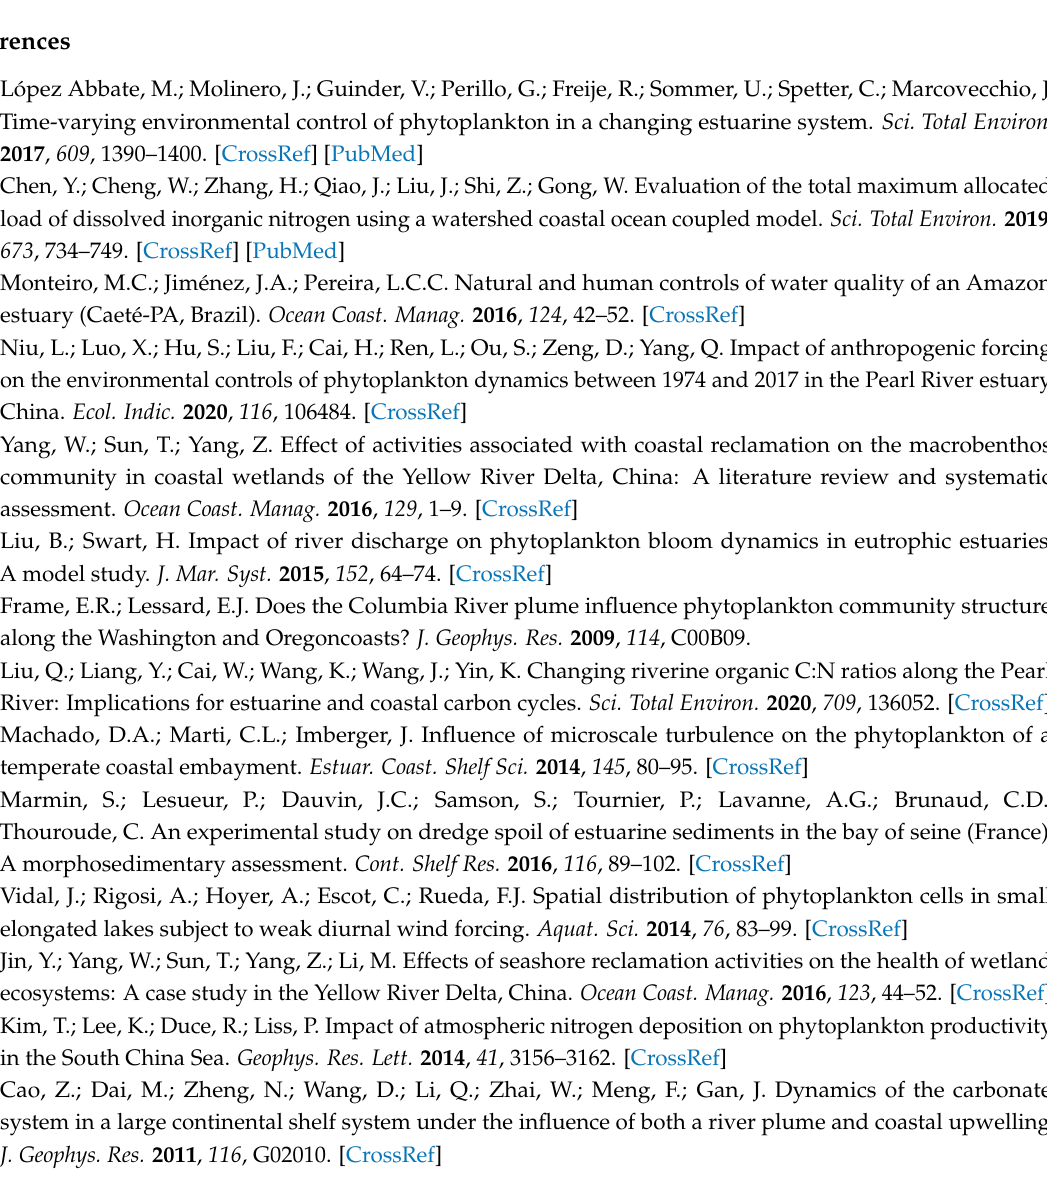
Table S1: Two end-member model results of nutrients in February in the Pearl River estuary, Table S2: Two end-member model results of nutrients in May in the Pearl River estuary, Table S3: Two end-member model results of nutrients in August in the Pearl River estuary, Table S4: Two end-member model results of nutrients in November in the Pearl River